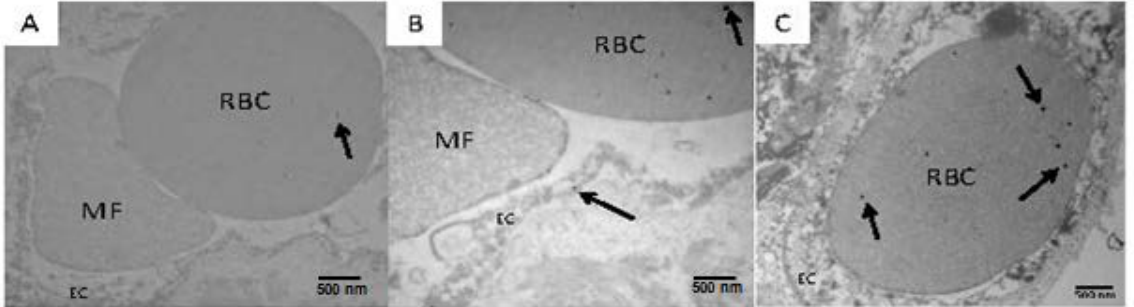
Figure 5. The integrity of myocardial cells was ill-preserved in human samples ( A – C ), however, nanosized particles could be seen in luminal red blood cells (RBC) (arrows on RBC in A – C ) and in adjacent endothelial cells (EC) (arrow on EC in B ) of an 11 years old MCMA girl (arrows point to the nanosized 14 nm in diameter particles). Luminal microfragments (MF) of unidentified cell origin are also common ( B ). Magnifications ×36,400. Scale bar = 500